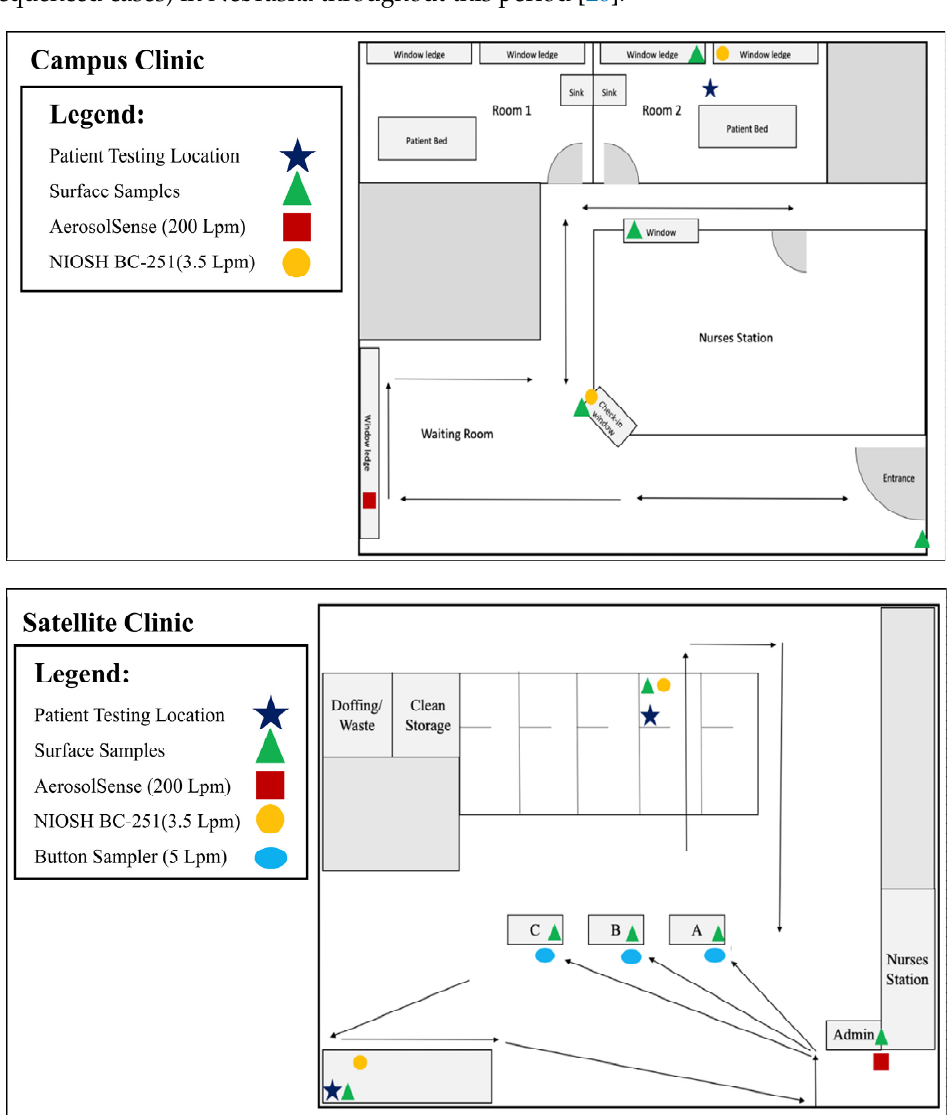
Figure 1. Schematics of sampling sites. Top panel depicts the campus clinic and bottom panel depicts the satellite clinic. Arrows indicate patient flow during entrance, check in, COVID-19 test collection, and exit. Legend indicates sample type collected at check-in desks and test collection locations within each clinic. In the satellite clinic, the only overlap of patient flow occurs near the entrance/exit and immediately inside the building. In the campus clinic, there is a high level of overlap in patient flow, as hallways are used for both entrance and exit.